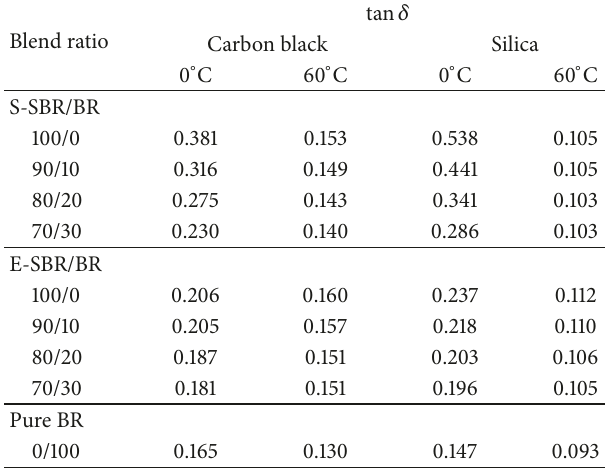
Table 4: Values of tan 𝛿 at 0 ∘ C and 60 ∘ C of the rubber vulcanizates. Blend